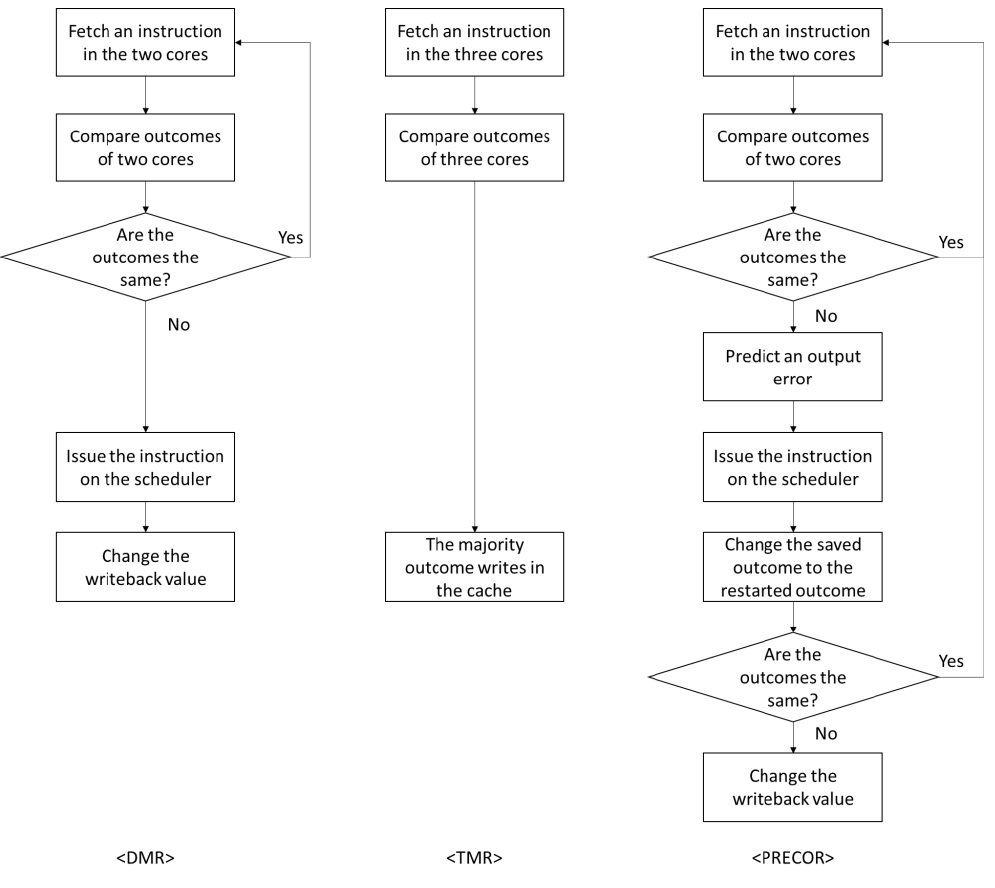
Figure 2. Flowchart of the proposed method.